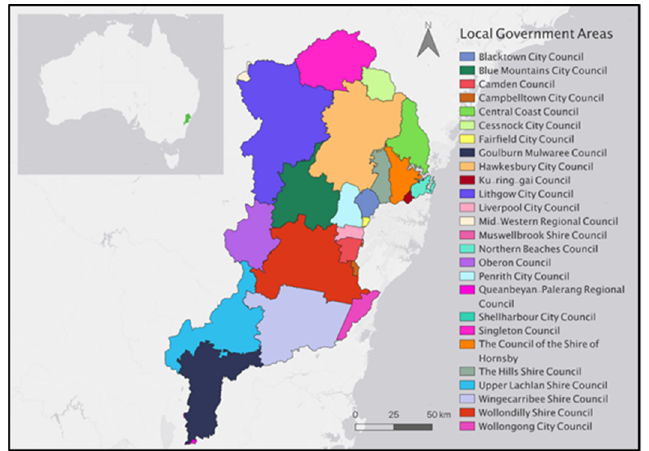
Figure 1. Australia’s Hawkesbury-Nepean Catchment, visualised through its twenty-six Local Government Areas (LGAs) as of 2022. Made using QGIS 3.24 software.